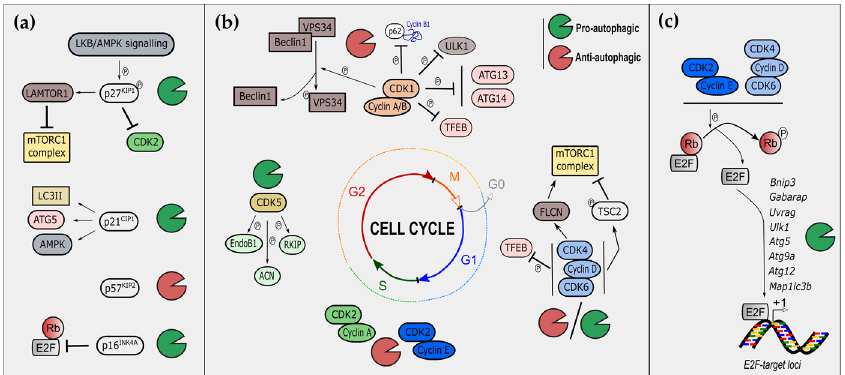
Figure 2. Regulation of autophagy by cell-cycle regulators. ( a ) Regulation of autophagy by cyclin- dependent kinase inhibitors (CKIs). Phosphorylation of p27 KIP1 by the LKB/AMPK signaling pathway participates in the recruitment of LAMTOR1 to lysosome and the subsequent inhibition of mTORC1, resulting in autophagy induction; p27 KIP1 is also pro-autophagic through CDK2 inhibition, while p21 CIP1 is pro-autophagic through mechanisms involving LC3II interaction, ATG5 stabilization, and AMPK phosphorylation. P57 KIP2 is anti-autophagic with unknown clear mechanisms. p16 INK4A mediates autophagy through the RB-E2F axis. ( b ) Regulation of autophagy by cyclin-dependent kinase (CDKs). CDK1 phosphorylates multiple key autophagic players, including VPS34, p62, ULK1, ATG13, ATG14, and TFEB, in inhibiting global autophagy. CDK4 phosphorylates folliculin (FLCN) modulates mTOR recruitment at lysosomal surface. CDK4-6 can also phosphorylate TSC2 to inhibit the mTORC1 complex. CDK5 phopho-substrates include Endophilin B1 (EndoB1), Acinus (ACN), and RKIP promoting autophagy. ( c ) Regulation of autophagy by RB-E2F axis. E2F target loci include many autophagy-encoding genes, namely BNIP3, GABARAP, UVRAG, ULK1/ATG1, ATG5, ATG9A, ATG12, and MAP1LC3B